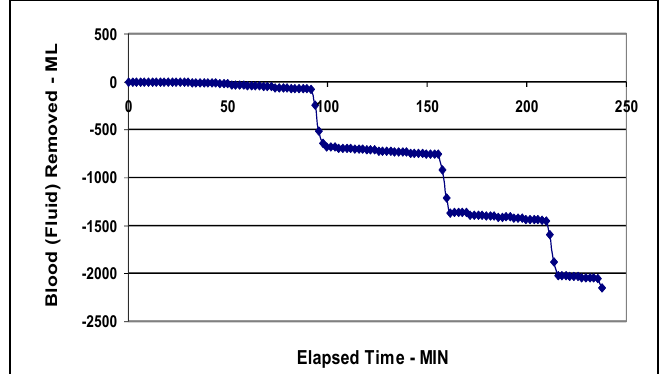
Fig. 4: Volume withdrawn.